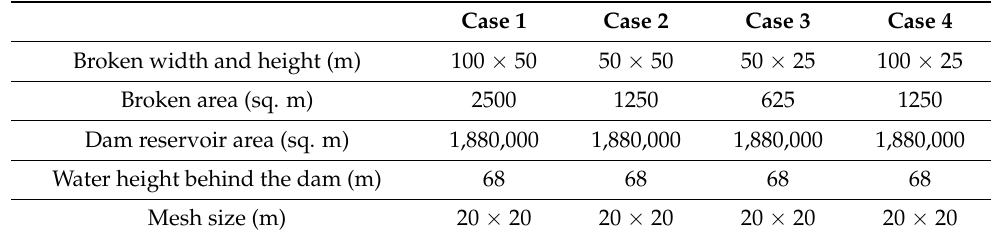
Table 2. Input data for dam-break simulations.